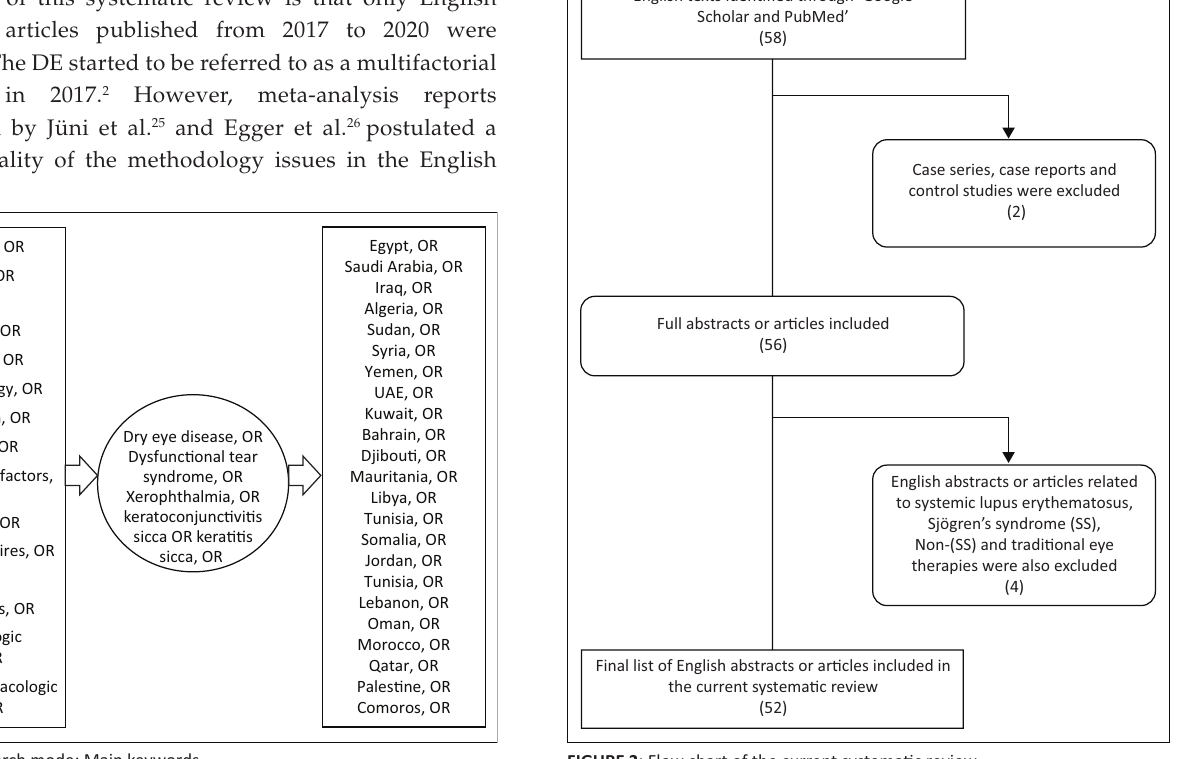
FIGURE 2: Flow chart of the current systematic